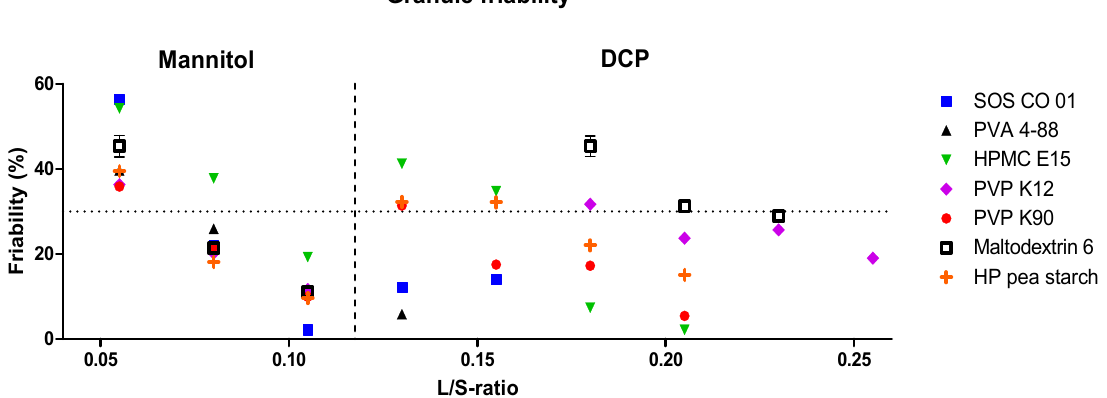
Figure 7. Friability of granules as a function of the L/S-ratios for the different binders illustrated for the mannitol and for the DCP formulation. The granule friability limit of 30% is illustrated with the dotted line, representing the limit to identify sufficiently strong granules [16]. Table 6. Overview of the numerical Y-variables for the PLS model per binder type. “L/S mannitol” and “L/S DCP” represents the lowest L/S-ratio required to meet the friability limit (30%).